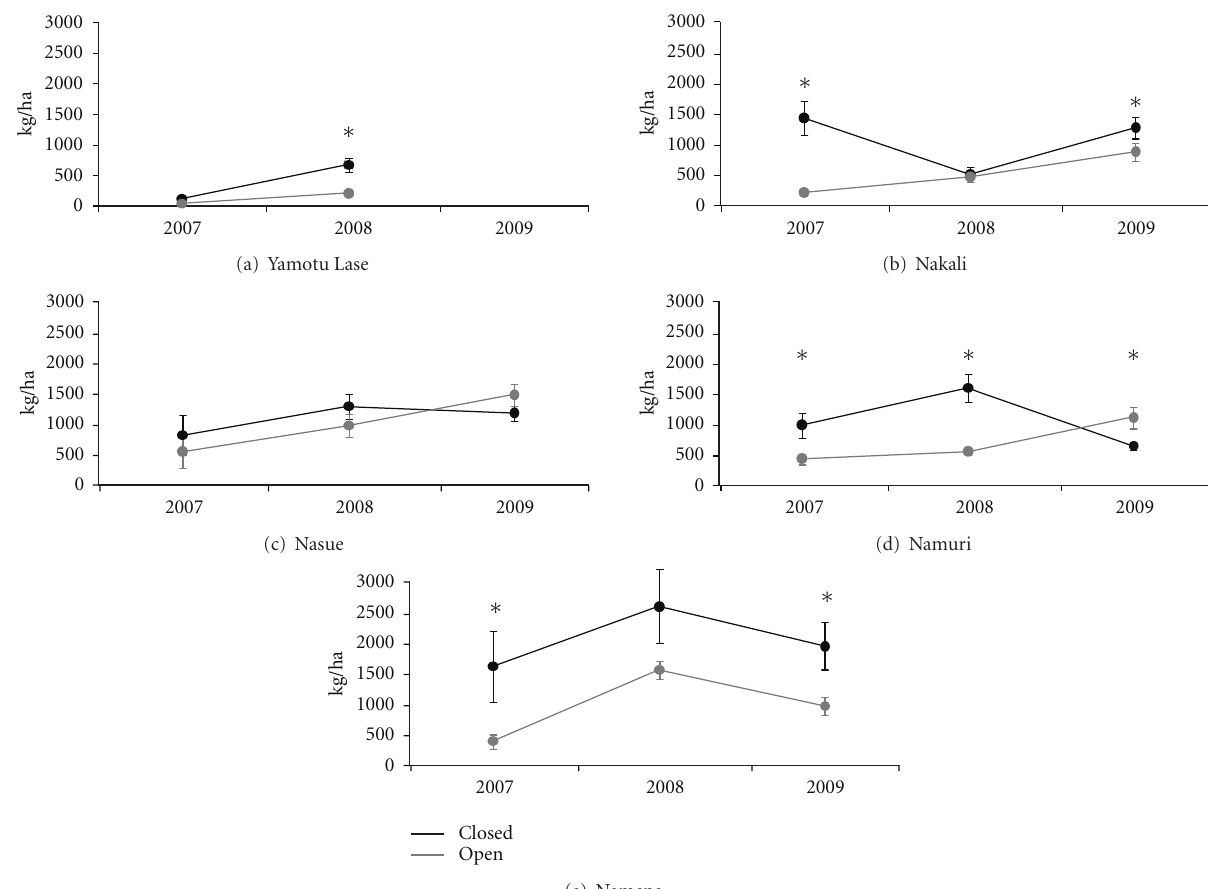
Figure 2: Mean total fish biomass (kg/ha) in closed (black) and adjacent open (grey) areas of: (a) Yamotu Lase tabu; (b) Nakali tabu; (c) Nasue MPA; (d) Namuri MPA; and (e) Namena MPA for survey periods between 2007 and 2009. Error bars are ± 1 standard error. ∗ denotes significant di ff erence to at least P < . 05 with PERMANOVA